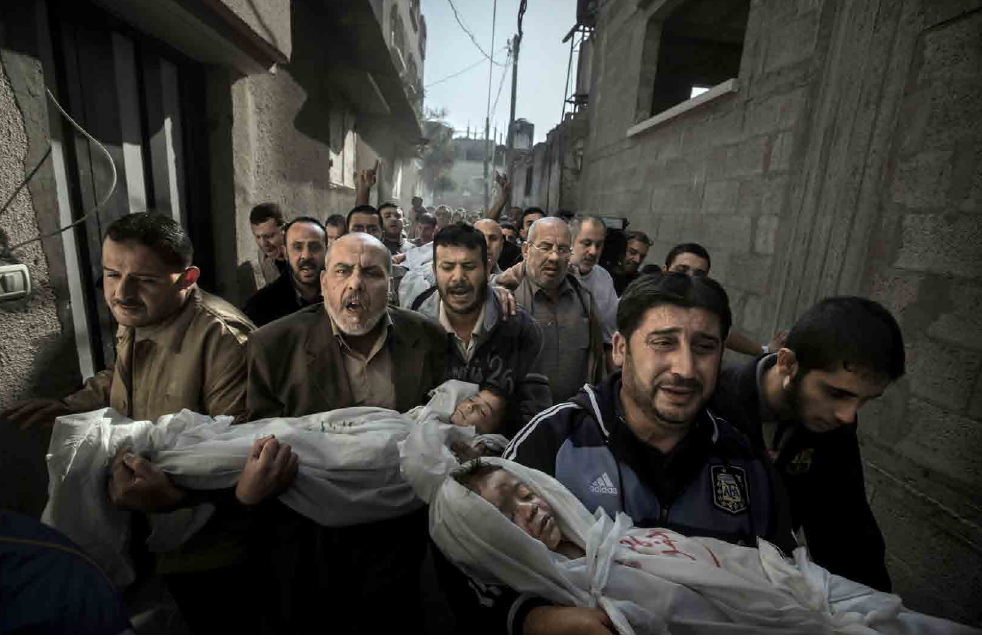
Fig. 1 Paul Hansen, Gaza Burial